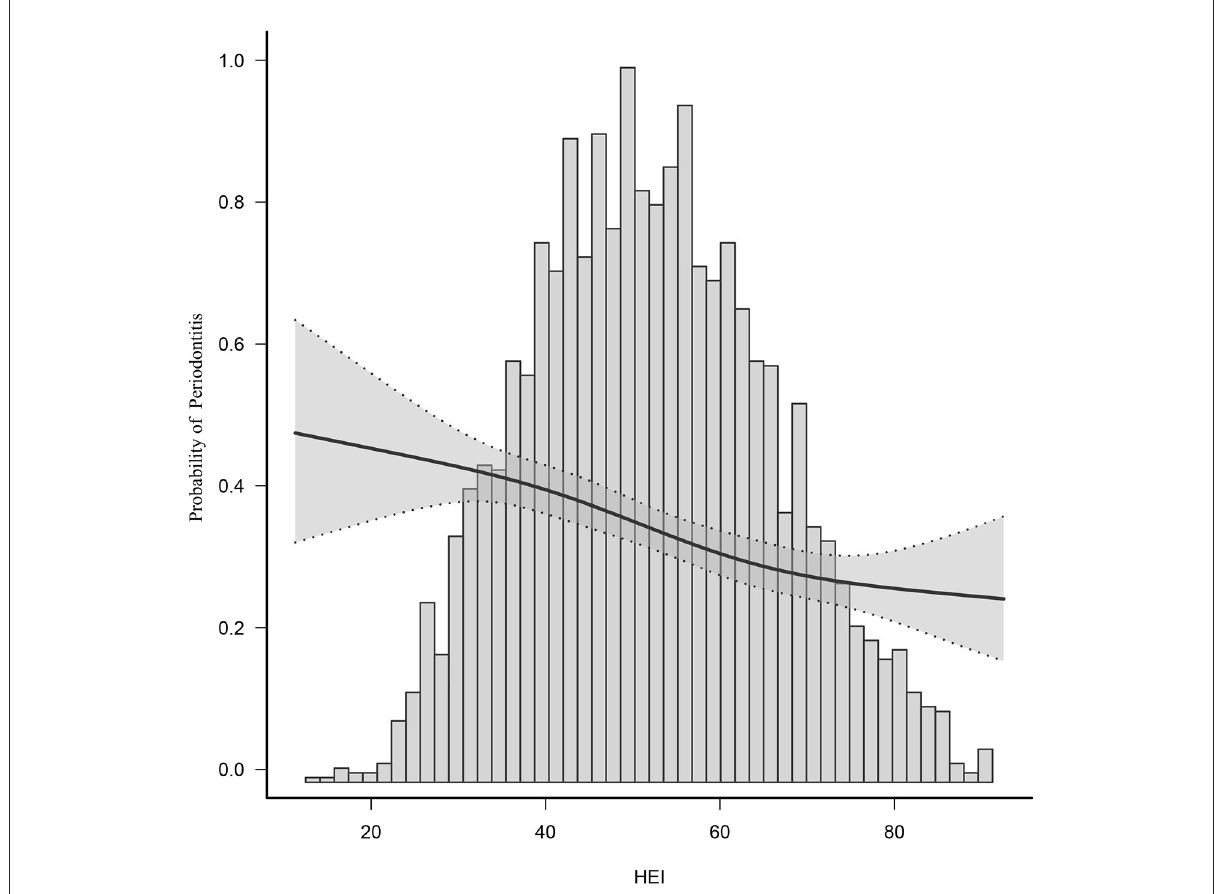
FIGURE2 Smooth curve fitting of periodontitis and